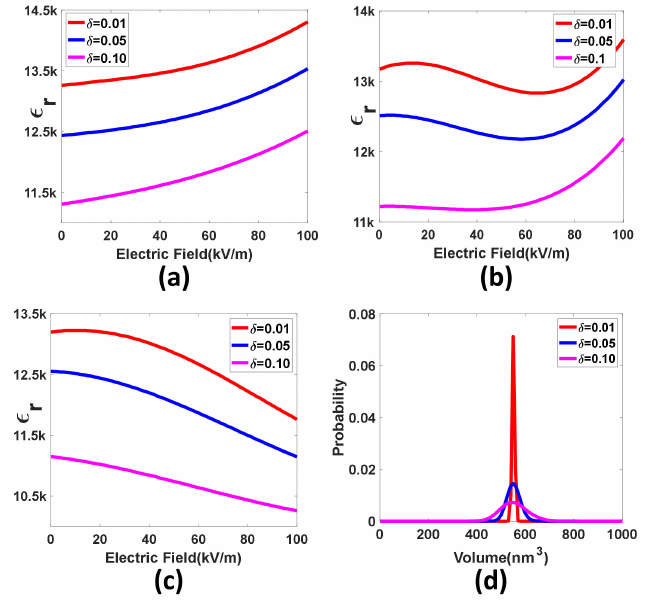
Figure 4. The dielectric response to the bias electric field for a different distribution width: ( a ) 201 kHz, ( b ) 676 kHz, and ( c ) 2 MHz. ( d ) The probability distribution of volume for a different distribution width. We performed the numerical simulations using the parameters calculated in Table